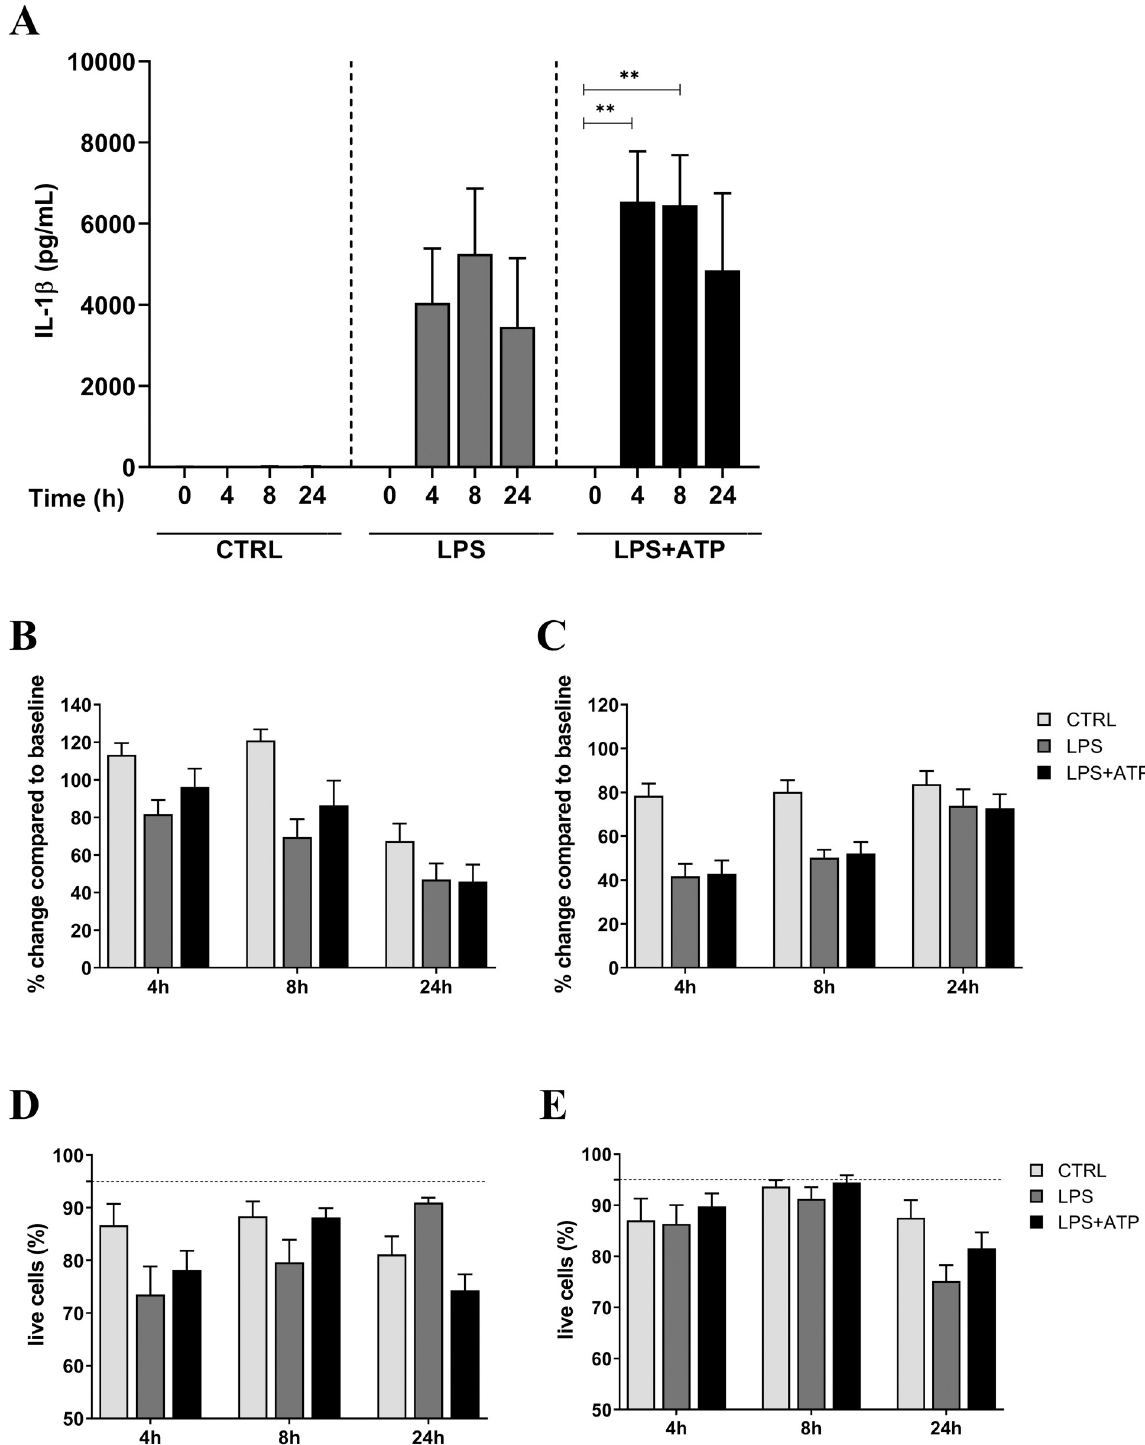
Fig 1. Inflammasome activation in whole blood cultures. (A) IL-1 β dynamics and kinetics after inflammasome activation with LPS or LPS +ATP in six donors. �� p < 0.008 analyzed by two-way ANOVA with Tukey’s multiple comparison test. (B, C) Cellular viability upon inflammasome activation in whole blood cultures. Cell percentage change over the course of 24h stimulation period compared to baseline (CTRL 0h) of monocytes (B) or neutrophils (C). (D, E) Cell viability stained with Annexin V/PI showing percentage of live cells for monocytes (D) and neutrophils (E). no significant differences between CTRL and LPS or LPS+ATP analyzed by mixed effects analysis with Tukey’s